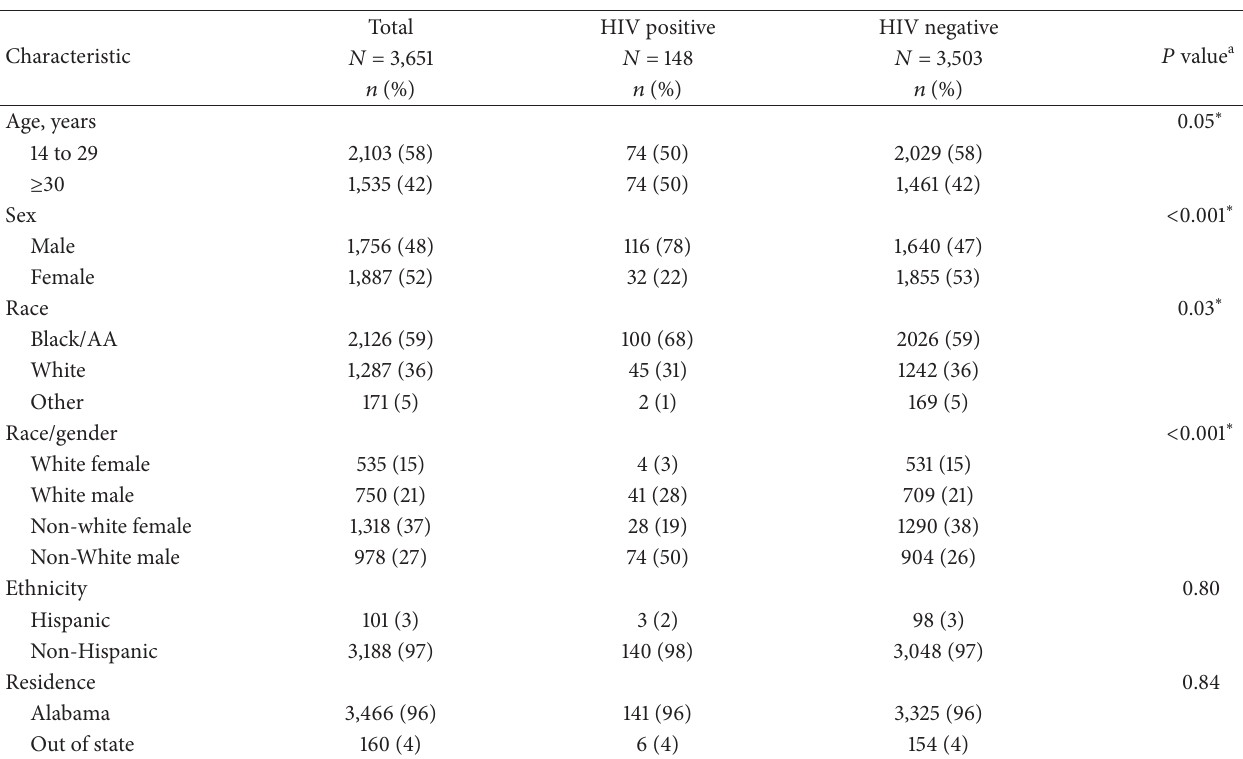
Table 2: Sociodemographic characteristics of clients who presented for HIV POC testing by test result, AL, 2007–2012.